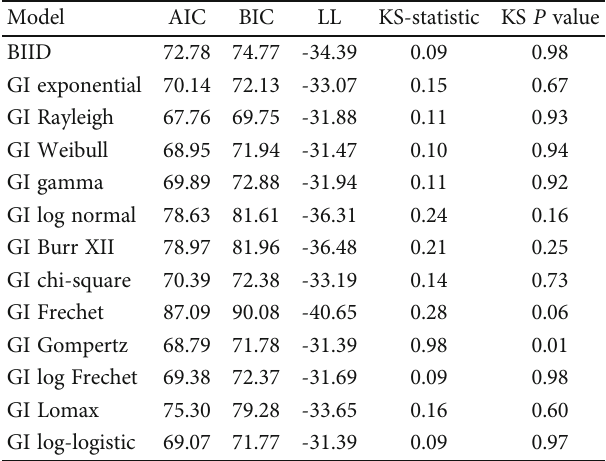
Table 16: Comparison of BIID with class of GGIDs using real dataset-1.